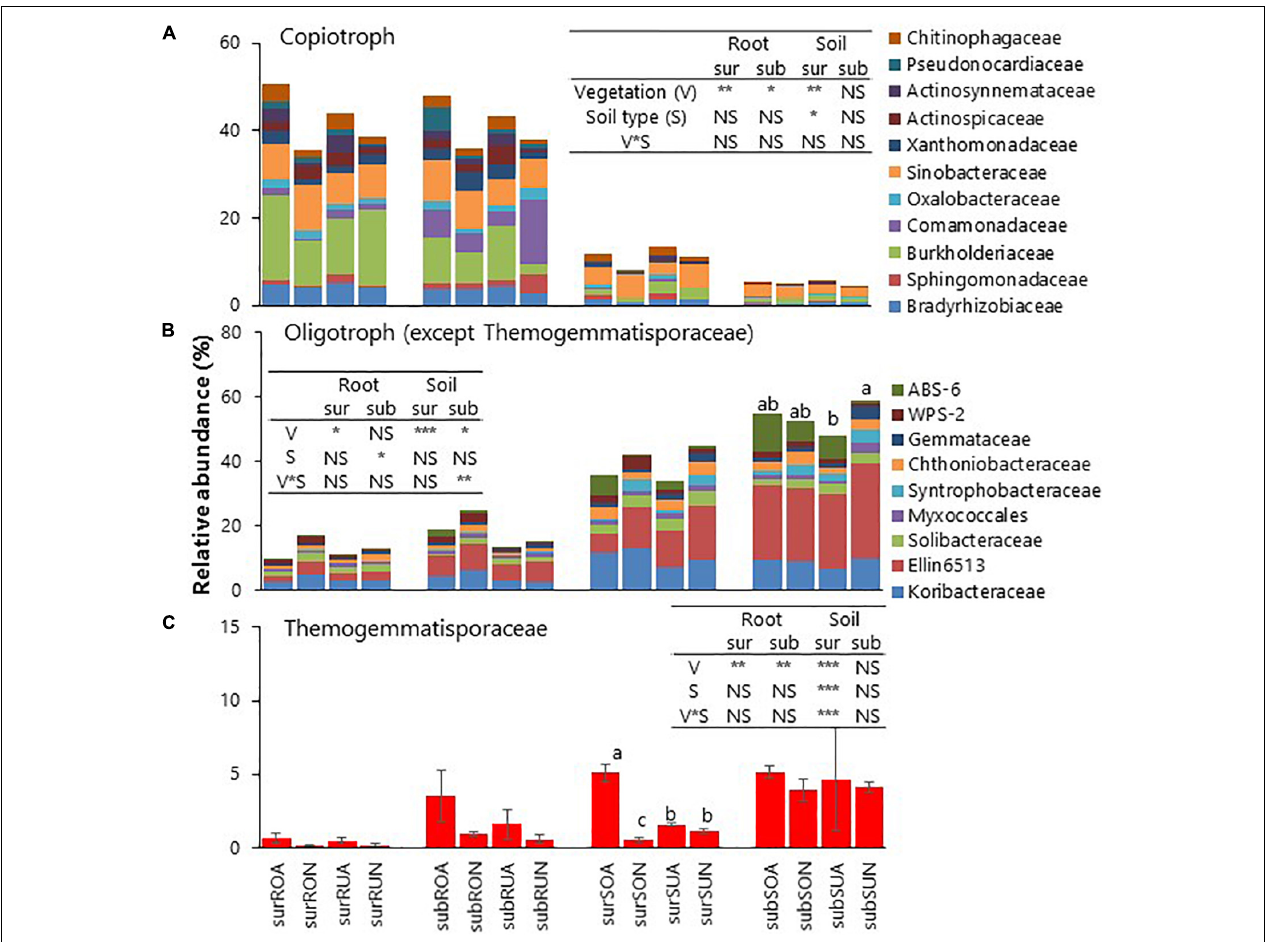
FIGURE 4 | Relative abundances of (A) copiotroph, (B) Oligotroph (except Thermogemmatisporaceae) and (C) Thermogemmatisporaceae. sur, sub, R, S, O, U, A, and N indicate surface, subsurface, Root, Soil, Oxisols, Ultisols, Acacia, and Native, respectively. NS, *, **, and *** in inserted tables indicate not significant, P < 0.05, P < 0.01, and P < 0.001, respectively, by two-way ANOVA. Different letters indicate significant differences ( P <